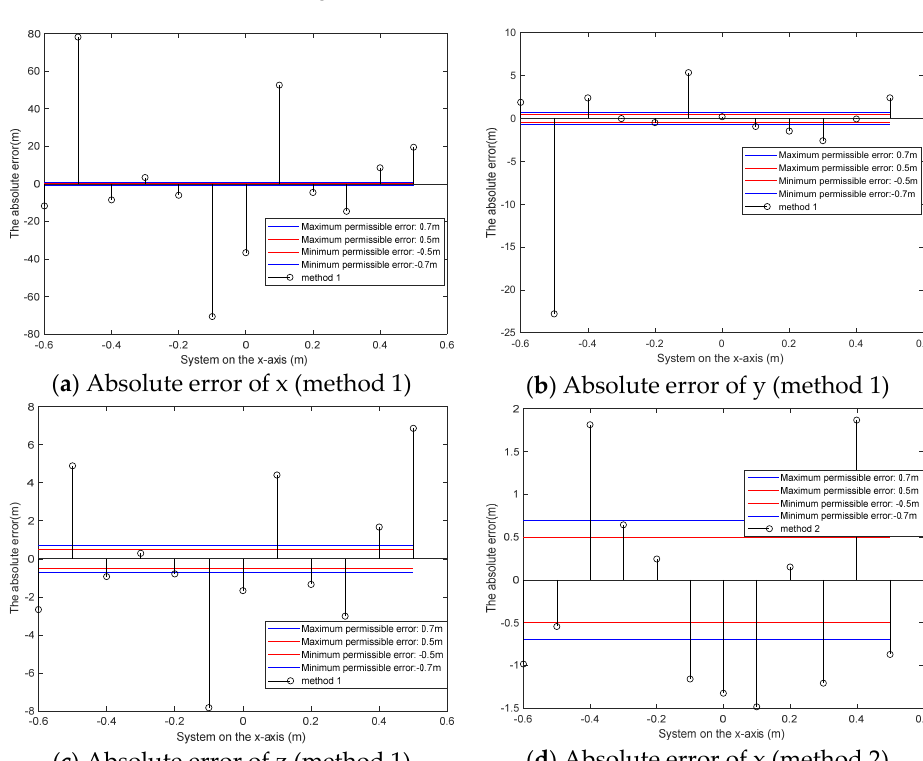
Figure 8. Localization result diagram.